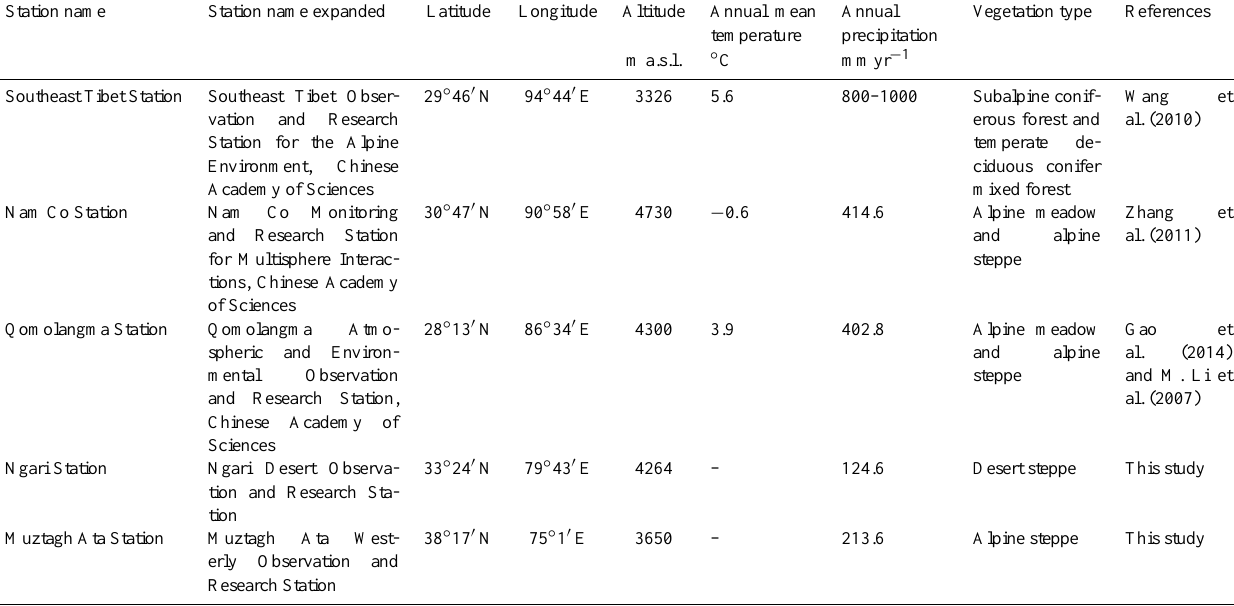
Table 1. Descriptions of the five precipitation sampling sites in the